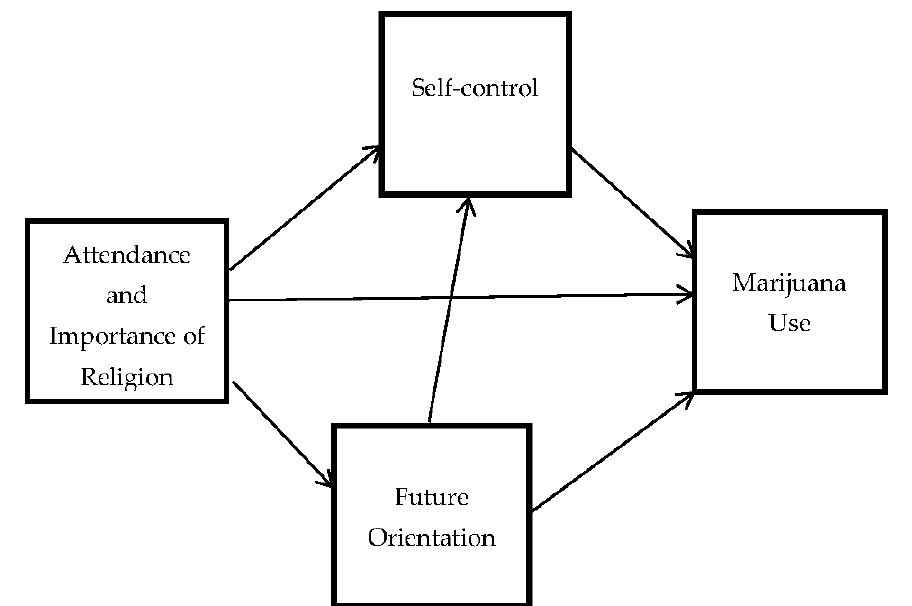
Figure 1. Religiosity, future orientation, self-control, and marijuana use.